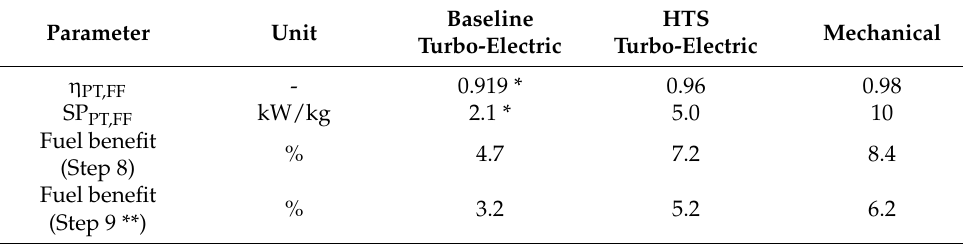
Table 18. PFC assessment results for more advanced power train